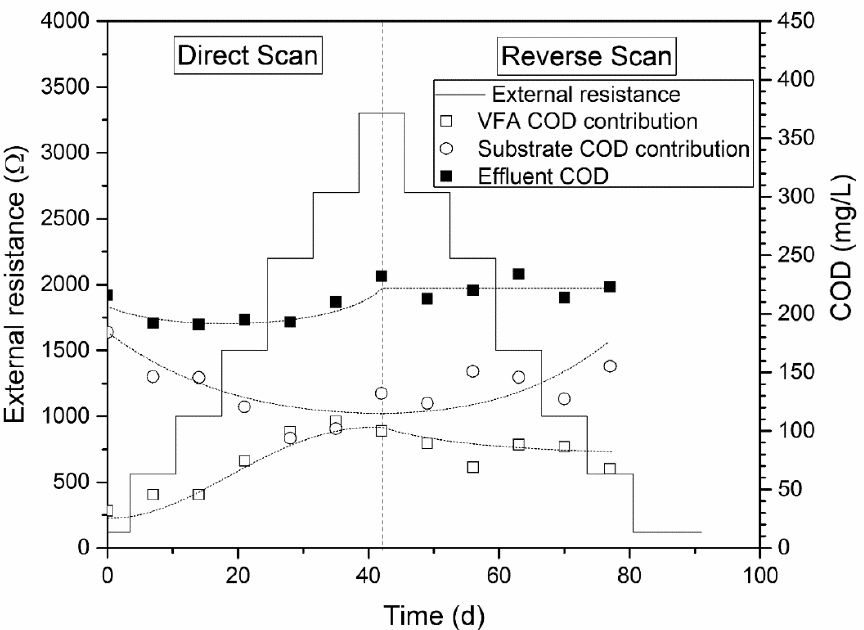
Figure 6. Acid chemical oxygen demand (COD), substrate COD, and total COD of the effluent at every external resistance.